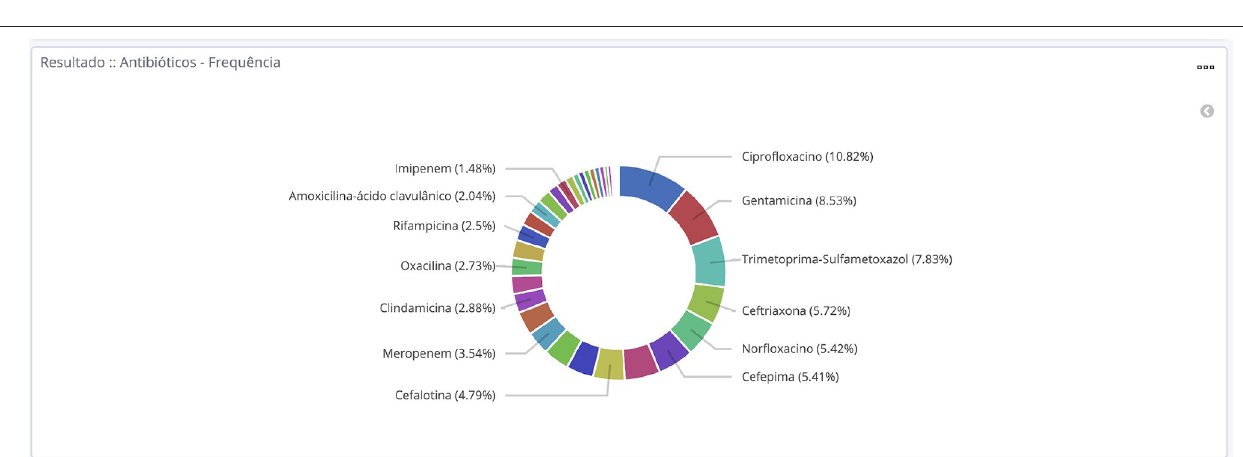
FIGURE 4 | Total frequency of antimicrobials tested during the year 2018 at hospitals participating in the BR-GLASS